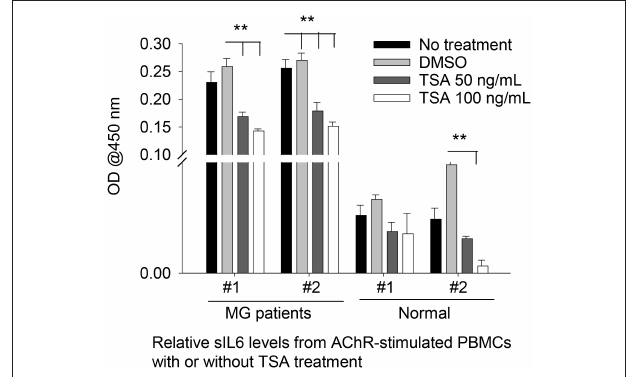
FIGURE 4 | Secreted IL-6 levels from human PBMCs treated with pan HDAC-i. Purified PBMCs from MG patients and healthy donors ( n = 2 per group) were incubated with TSA at 100ng/ml and 50ng/ml medium ex vivo for 24h and then stimulated with AChR for 16h. Secreted levels of IL-6 were then measured via ELISA. ** P < 0.01, ANOVA. The experiment was performed